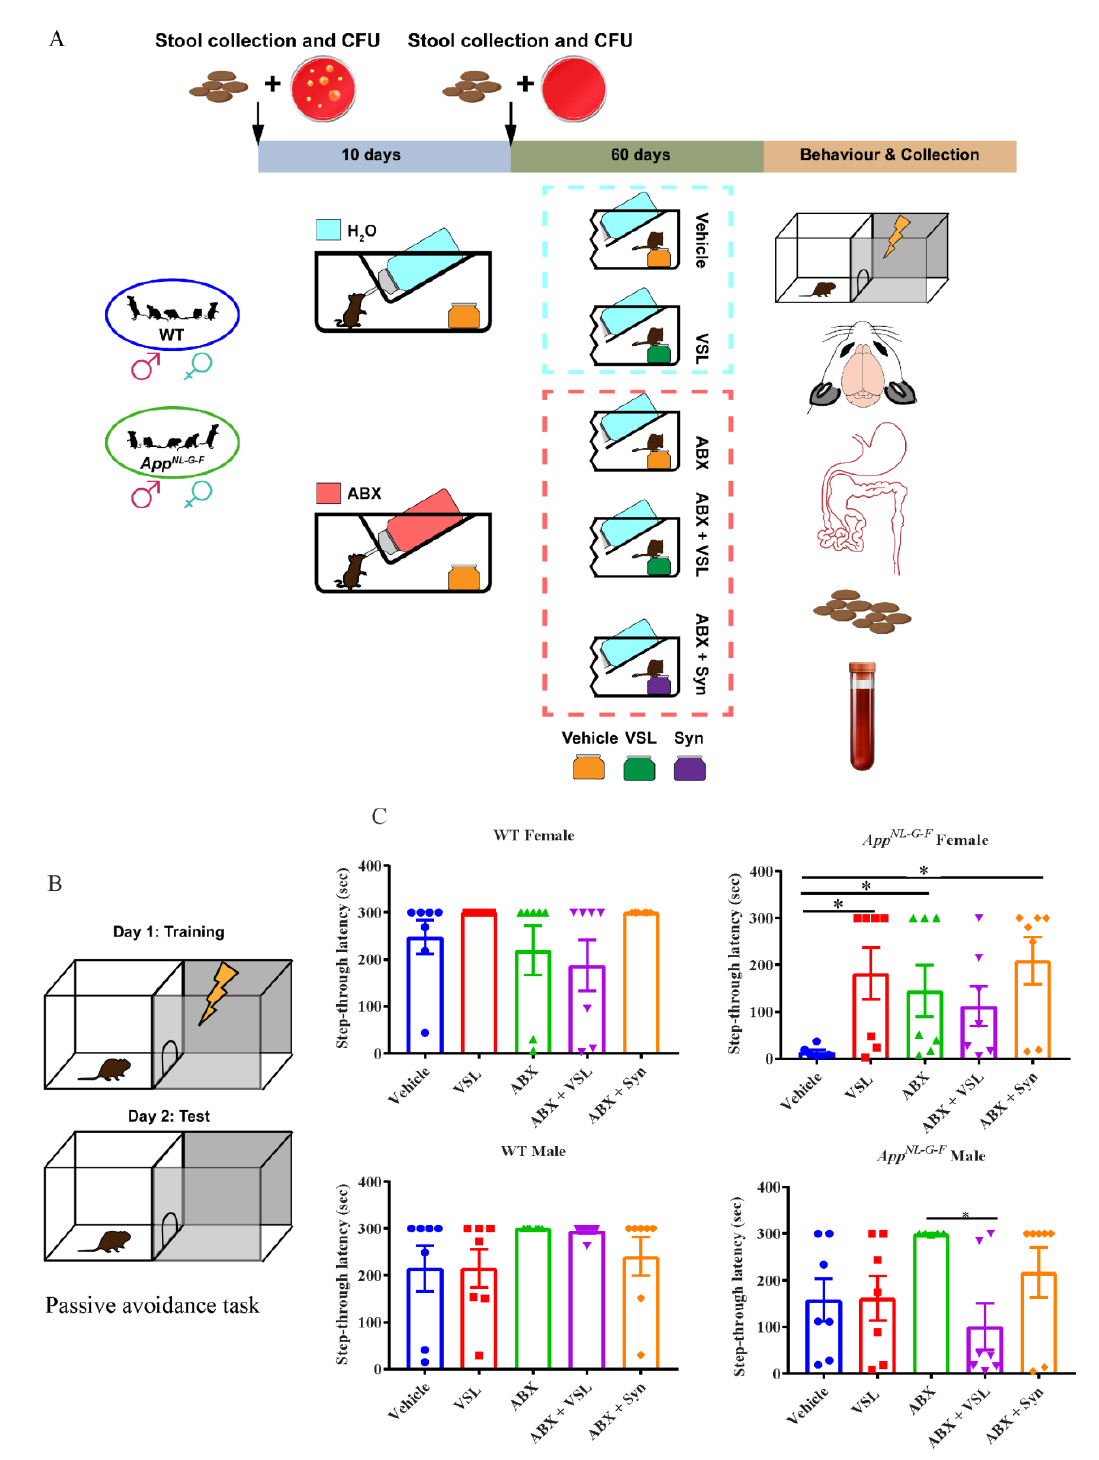
Figure 1. Study design and treatment effects of probiotic and antibiotics on learning and memory. ( A ) General experimental procedure and a timeline of the study. ( B ) Animals at 4–5 months of age were assessed for learning and memory using a passive avoidance task. The image shows the neurobehavior training setup, where a mild foot shock was used as an unconditioned stimulus on day 1 (training day) and the step-through latencies were measured when animals entered from a lit compartment to a dark compartment. ( C ) The passive avoidance task results are shown as step-through latency on day two and are expressed as mean ± SEM. Significant differences were determined by one-way analysis of variance, * p < 0.05 ( n =